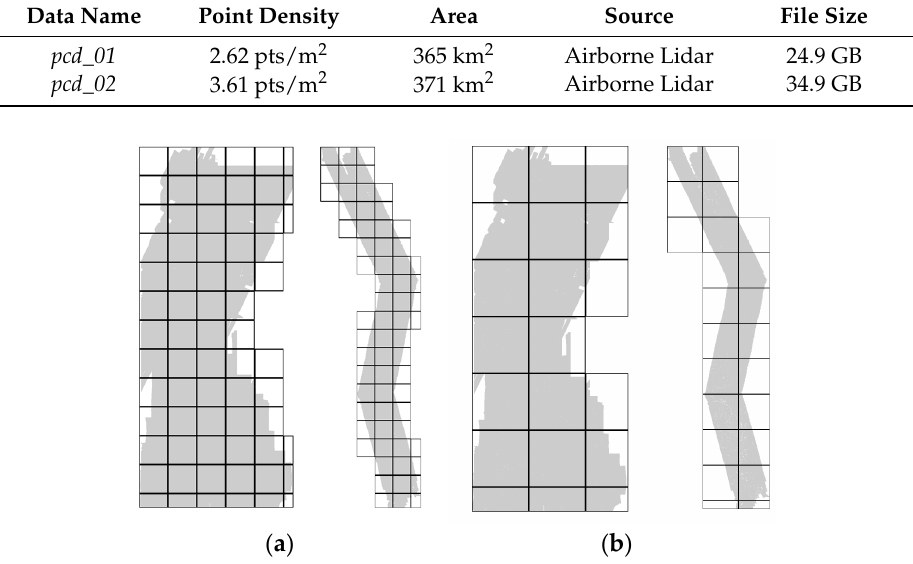
Table 4. Training time and the optimal decomposition granularities of different datasets.